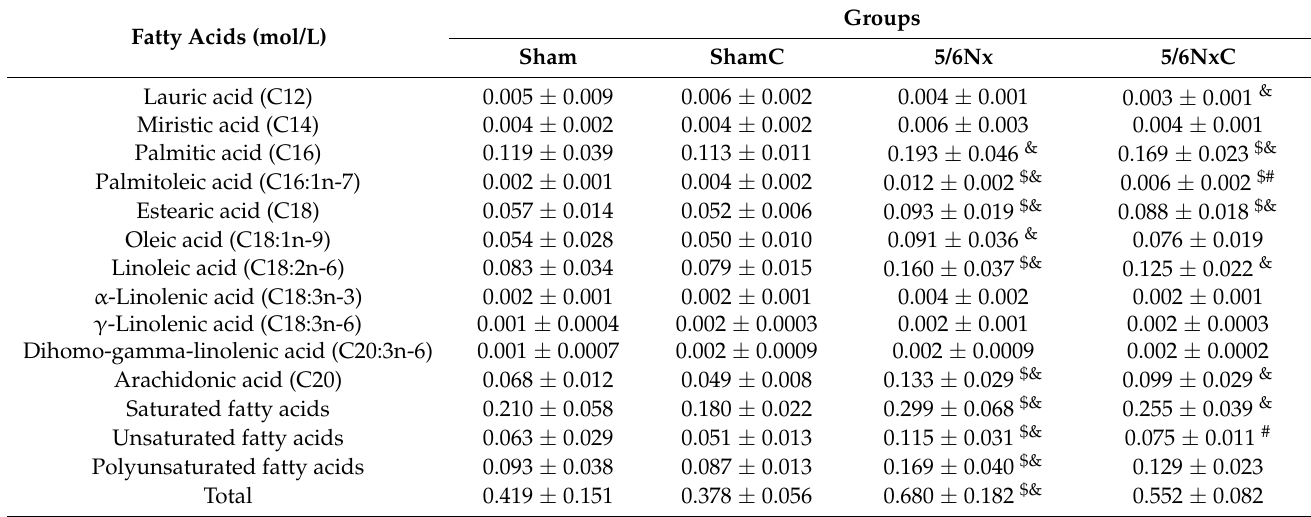
Table 3. Plasma fatty acids